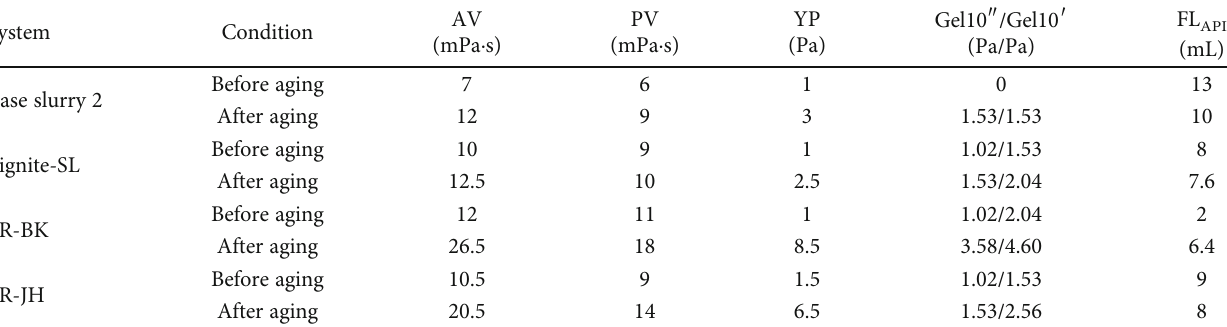
Table 6: Experimental results of fi ltrate reduces